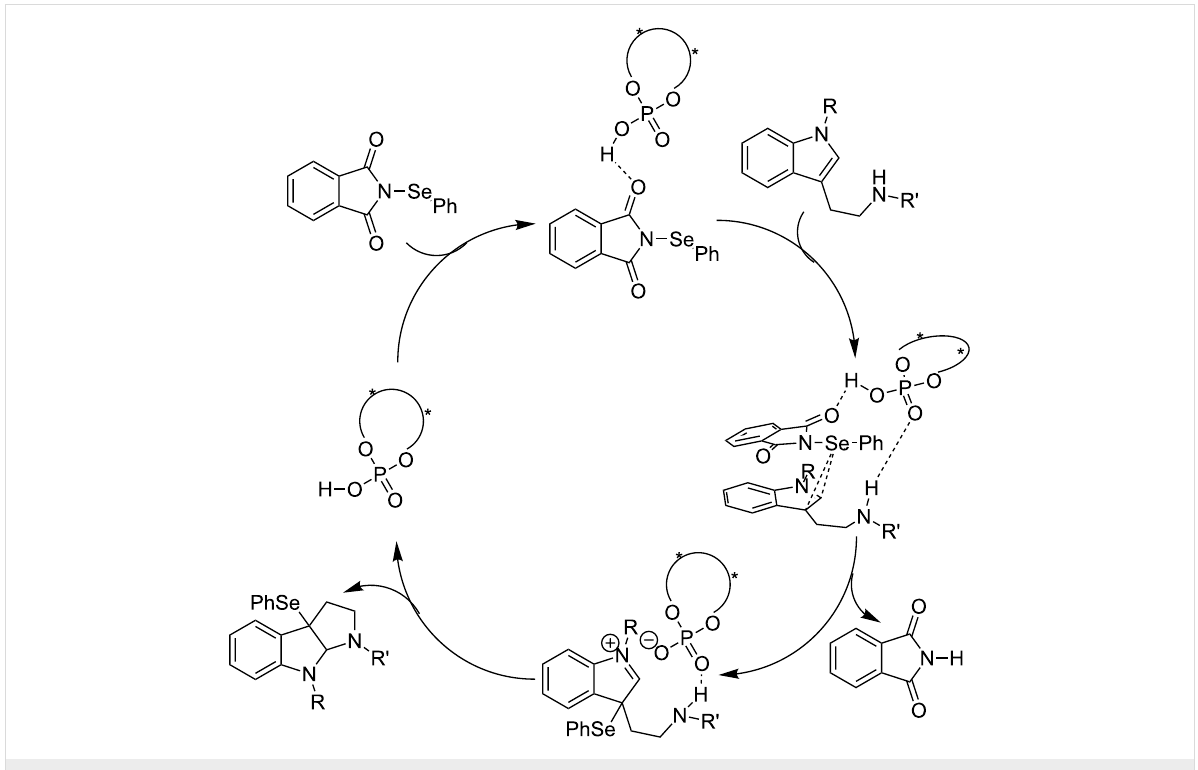
Scheme 1: The plausible reaction mechanism.